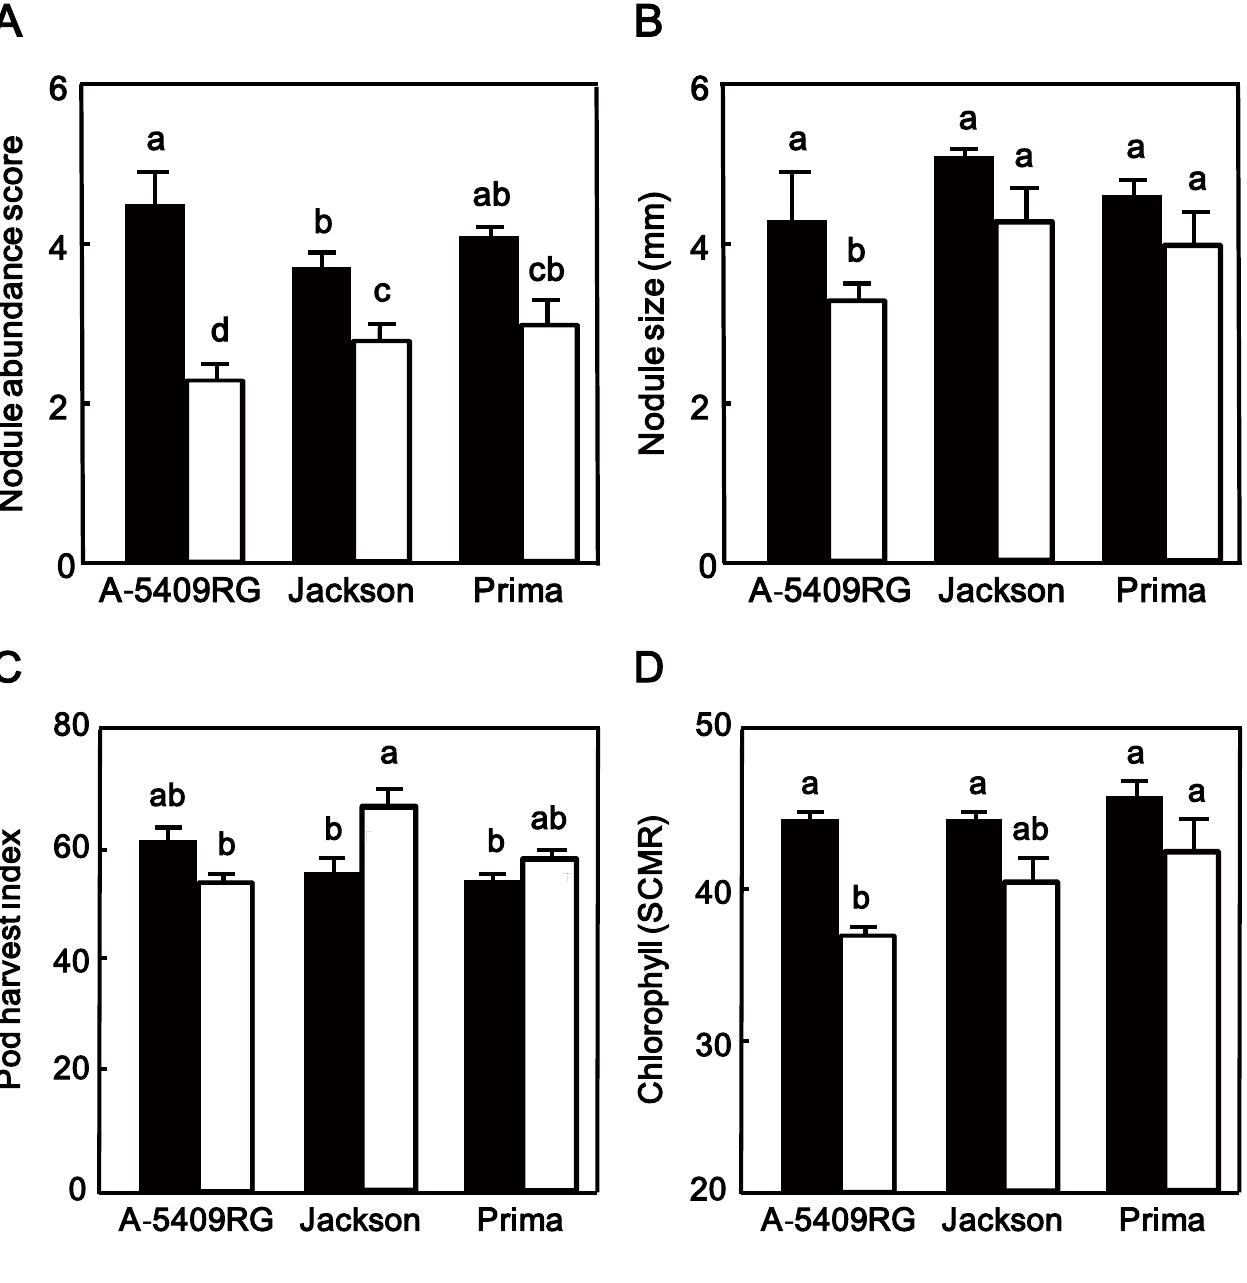
Figure 4. ( A ) Nodule abundance; ( B ) nodule size; ( C ) pod harvest index and ( D ) leaf chlorophyll content (SCMR) of plants from field-grown soybean cultivarsA-5409RG Jackson and Prima 2000 either exposed to watered (closed bars) or drought (open bars) conditions. Data shown for nodule abundance and size represent the mean ± SEM of six plants per plot after exposure for one month to either well-watered or drought conditions. Data shown for pod harvest index are the mean ± SEM of plants from a single row per plot and data for chlorophyll represent the mean ± SEM of six plants per plot with chlorophyll measurements replicated three times. Means followed by the same letter on bars are not-significantly different tested by LS means Student’s t -test ( p =